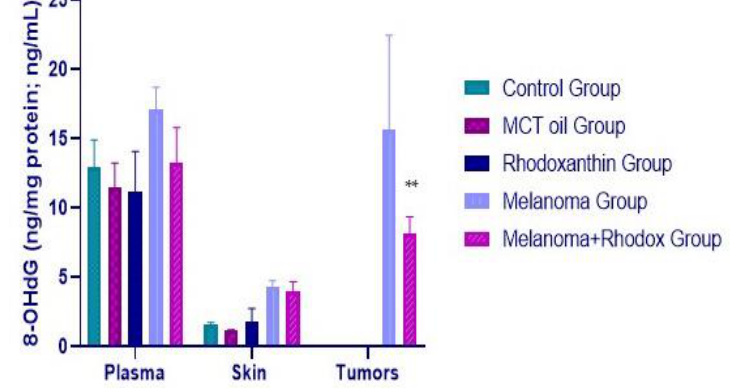
Figure 8. 8-OHdG variation within the groups. Statistical significance level ** p <